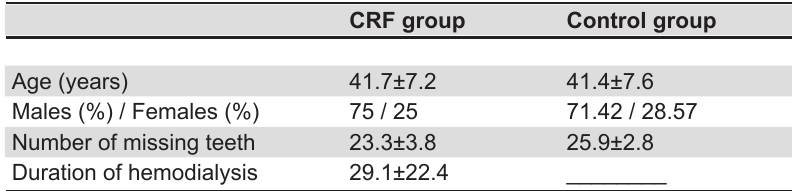
Table 1- Characterization of patients with chronic renal failure (CRF) and controls